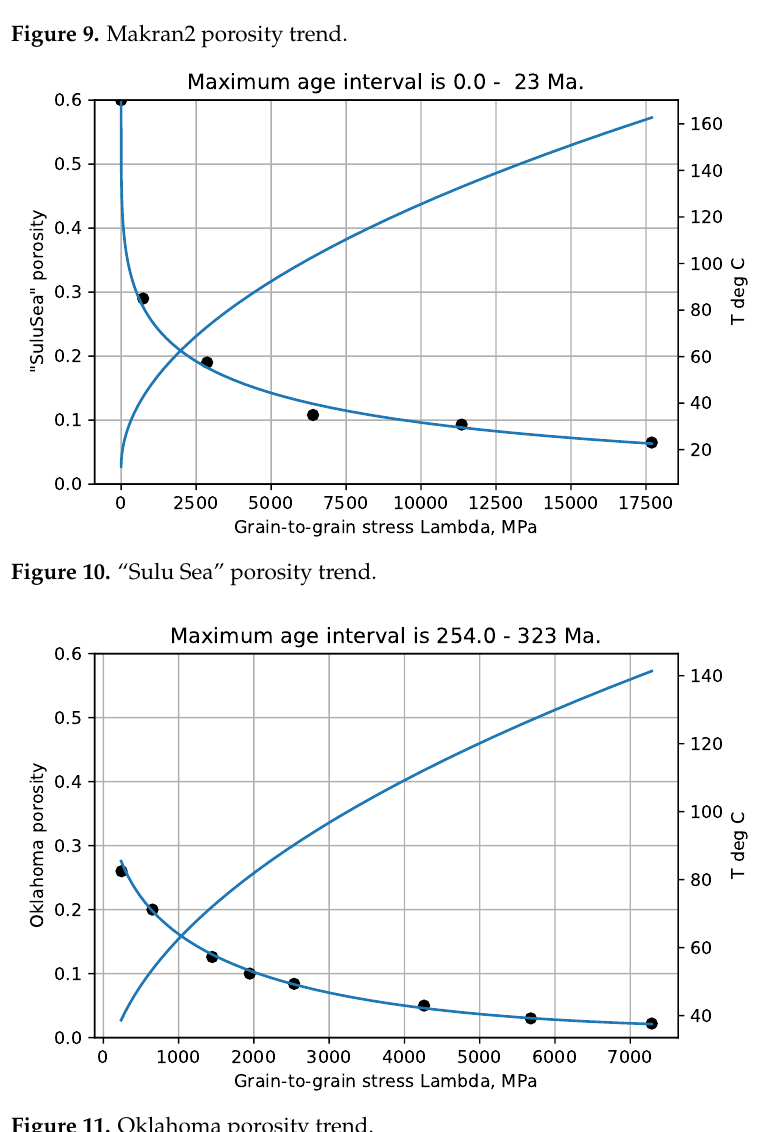
Figure 11. Oklahoma porosity